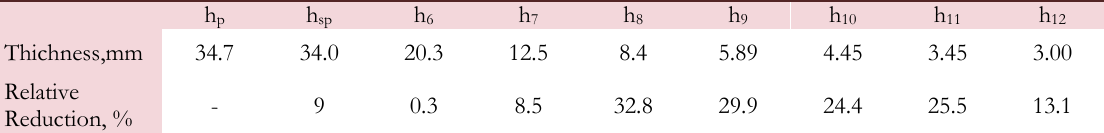
Table 2: The deformation mode in finishing group rolling for strip 3x1250 mm, steel 08U.